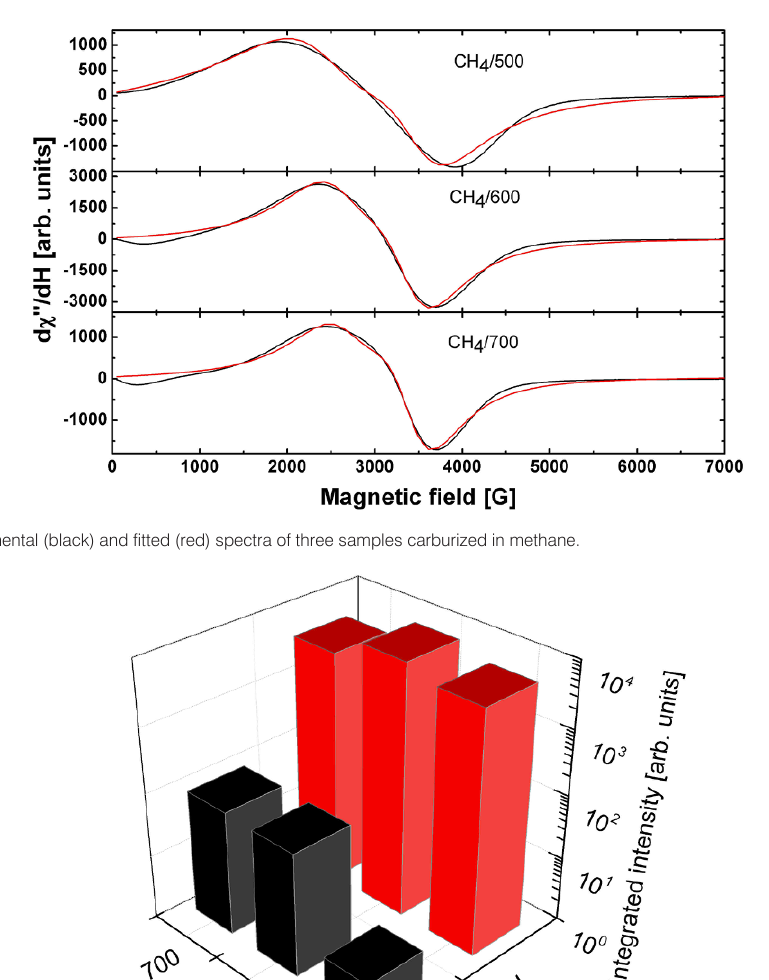
calculated for a unit mass for six studied samples. Due to large differences in values of int